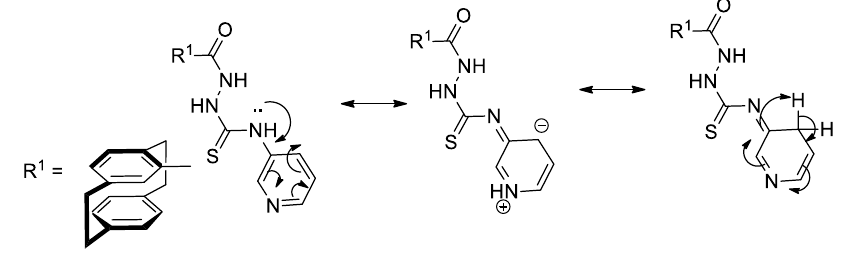
Figure 8. Molecular structure of compound 3c identified according to IUPAC nomenclature as methyl ( E )-2-(( E )-3-(1,4(1,4)-dibenzenacyclohexaphane-1 2 -carboxamido)-4-oxo-2-(pyridin-3-ylimino)thiazolidin -5-ylidene)acetate.